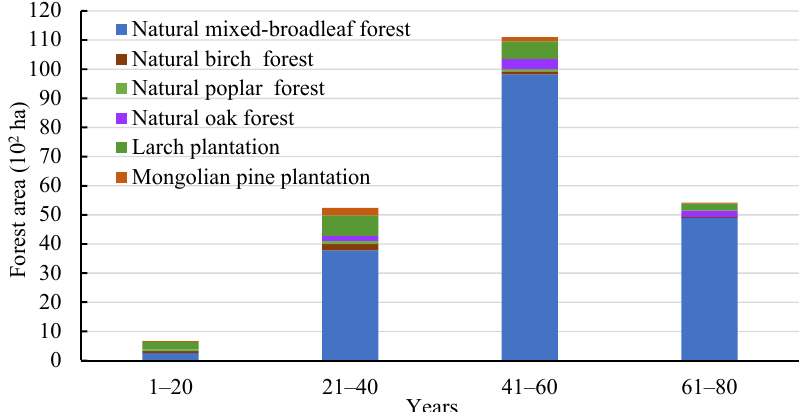
Figure 1. Initial distribution of forest areas by different forest types and age classes.